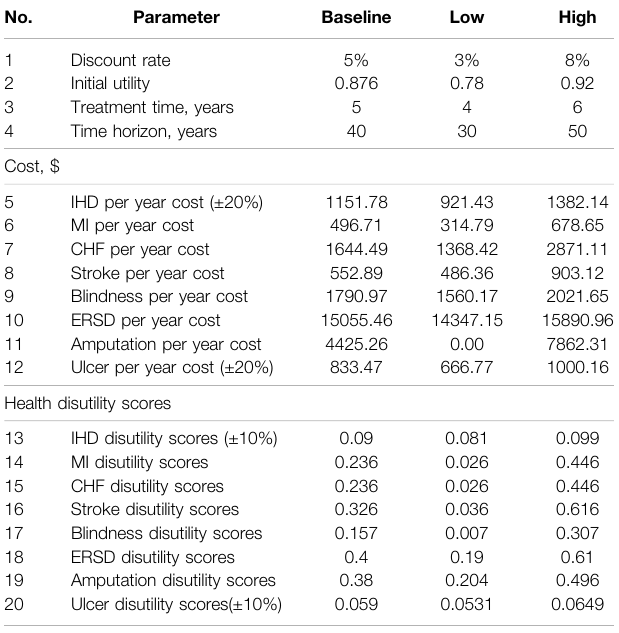
TABLE 5 | Parameters for sensitivity